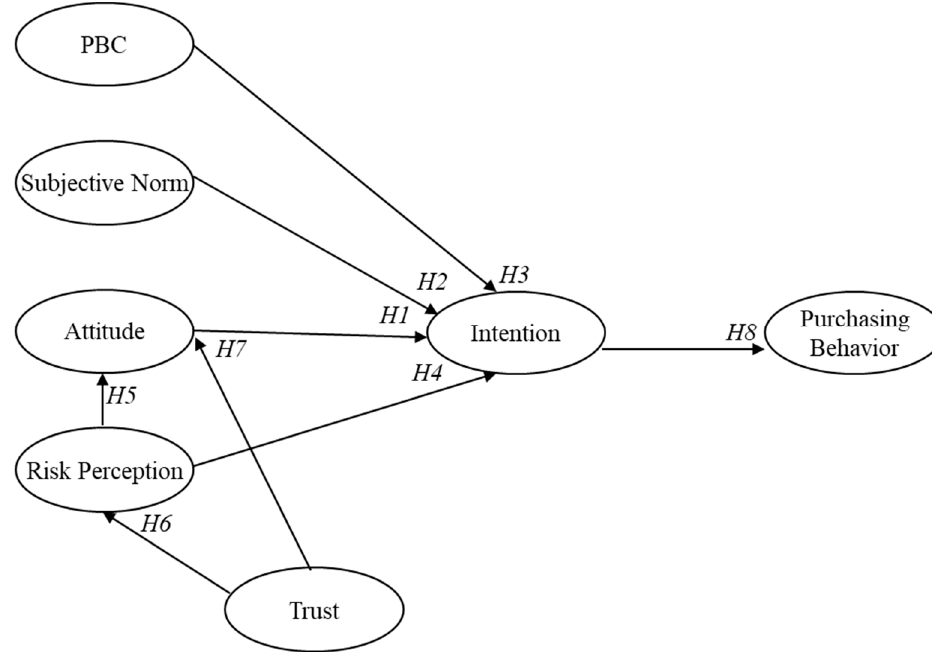
Figure 1. The extended hypothesized model, PBC: perceived behavioral control.